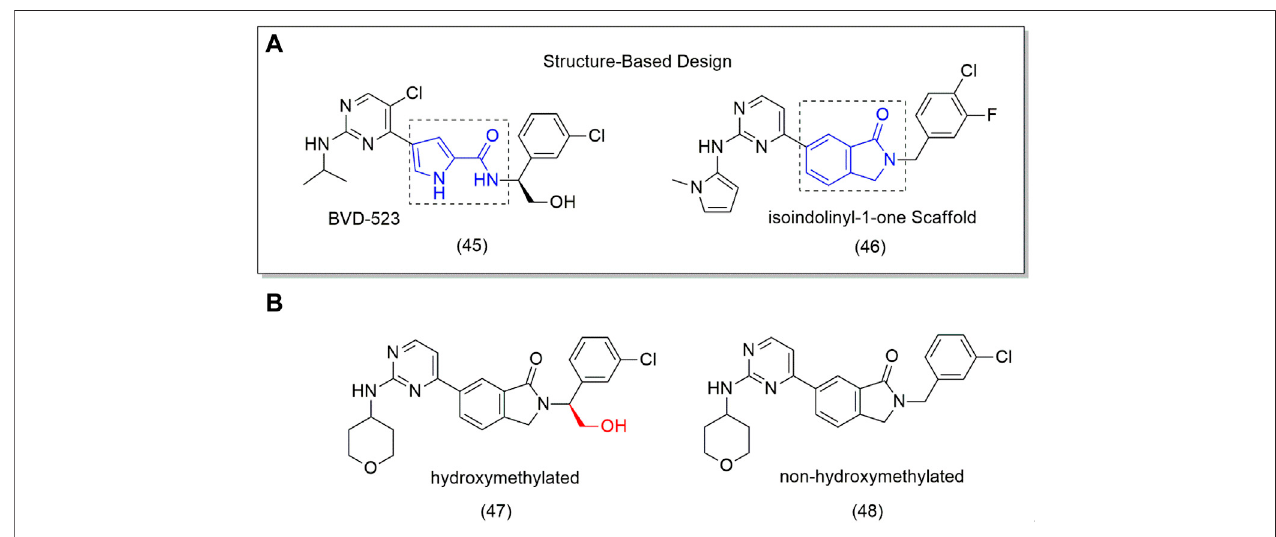
FIGURE 3 | (A) Drug Design from 4-pyridone to isoindolinyl-1-one (46). (B) ERK1/2 inhibitors ( 48 ) and the hydroxymethyl compound ( 9 ).